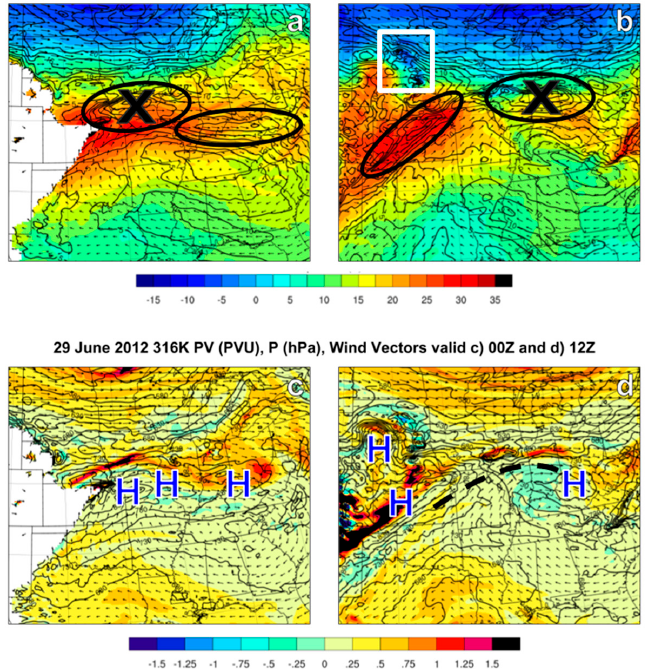
Figure 18. WRF-ARW 18 km simulated 316 K temperatures (°C, color fill), wind isotachs (black lines in m/s), and wind vectors for ( a ) 00Z and ( b ) 12Z 29 June, as well as simulated 316 K potential vorticity (PVU, color fill), pressure (black lines in hPa), and wind vectors valid at ( c ) 00Z and ( d ) 12Z 29 June. The white-filled areas in panels ( a , c ) represent locations where the isentropic surface is interrupted by higher terrain. Black ovals indicate the location(s) of mid-level jetlets (MLJ). Black “X”s indicate the location of the MLJ associated with derecho development. The white box shows the relative location of the cold pool which triggered the derecho. Black dashed lines indicate the EMLF, and blue “H”s represent meso-highs being ejected from the main EML.